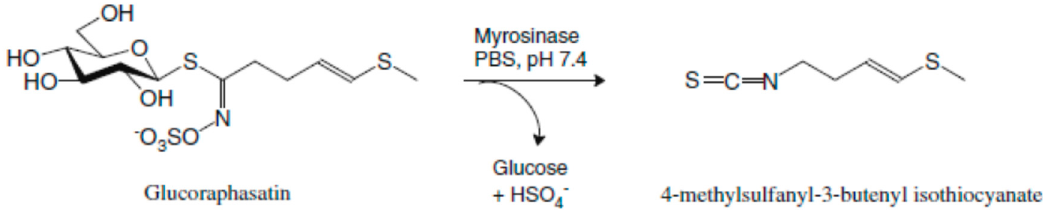
Figure 1. The hydrolysis process of glucoraphasatin by myrosinase produces 4-methylsulfanyl-3-butenyl isothiocyanate, raphasatin. Adapted from Razis et al. [20].